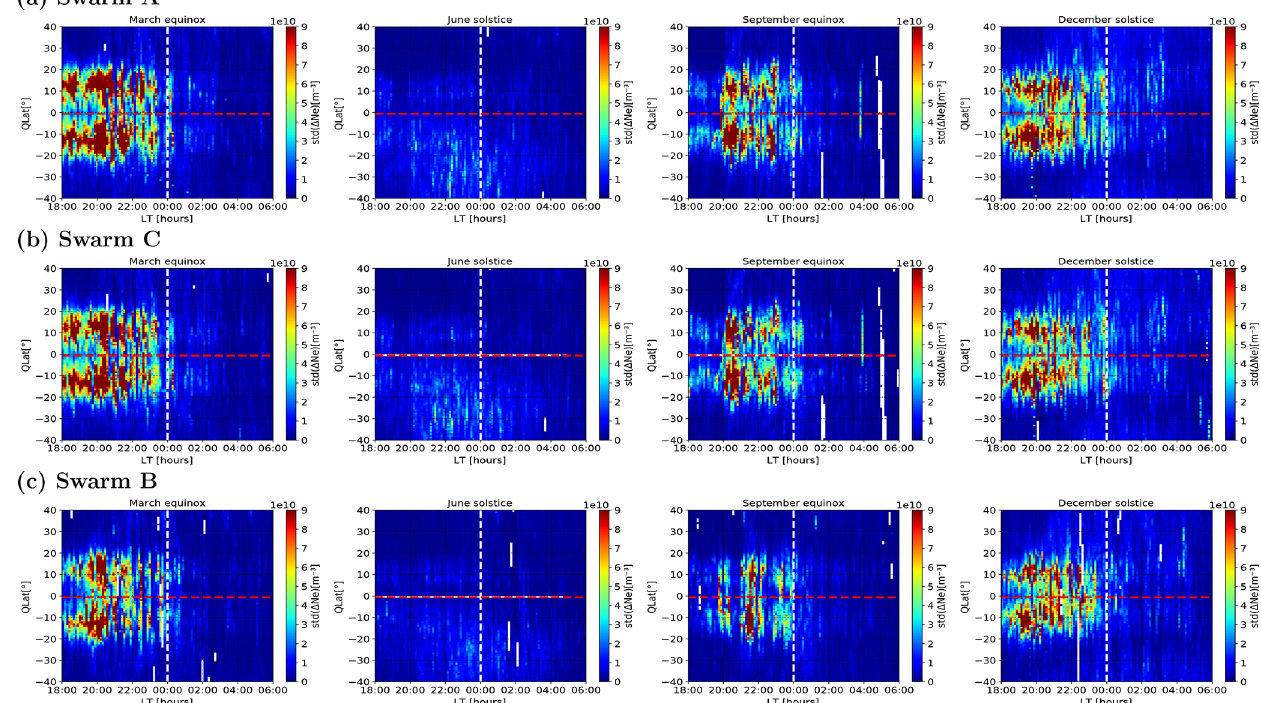
Figure 11. Quasi-dipole latitude and local time distributions of std( (cid:49)N e ) for Swarm A, C, and B for the years from 2014 to 2018. The dotted white vertical line represents midnight, and the dotted red horizontal line represents the quasi-dipole latitude of Jicamarca ( ≈ − 0 . 6 ◦ ). The white spaces represent data